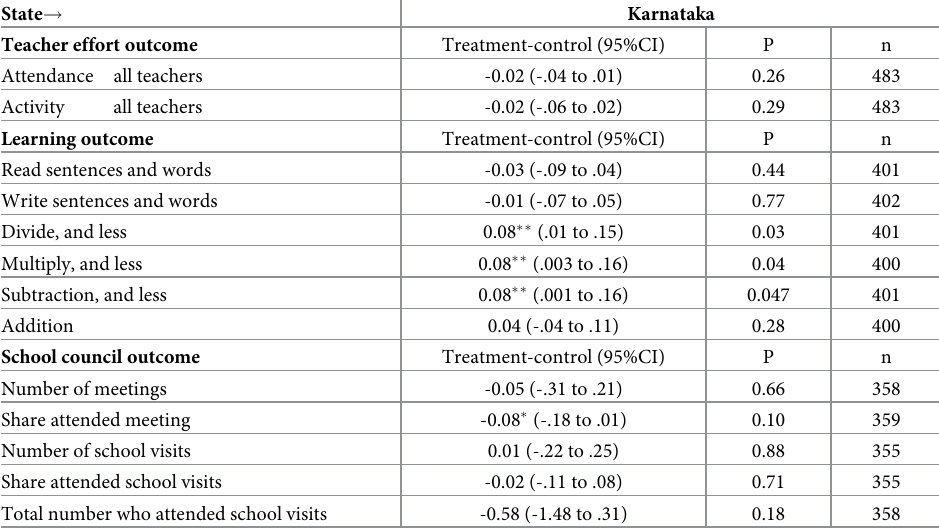
Table 5. Difference-in-differences linear regression results in Karnataka where change in outcome from baseline to follow-up is dependent variable. State ! Karnataka Teacher effort outcome Treatment-control (95%CI)